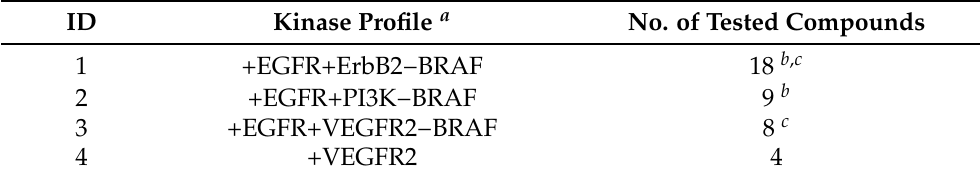
Table 2. Definitions of kinase profiles and the numbers of screening compounds selected for each profile. ID Kinase Profile a No. of Tested Compounds 1 +EGFR+ErbB2−BRAF 18 b , c 2 +EGFR+PI3K−BRAF 9 b 3 +EGFR+VEGFR2−BRAF 8 c 4 +VEGFR2 4 a + and −indicate targets and anti-targets, respectively. b Three compounds are identical between Profiles 1 and 2 but were independently selected from the docking calculations against both profiles. c One compound is identical between Profiles 1 and 3 but was independently selected from the docking calculations against both